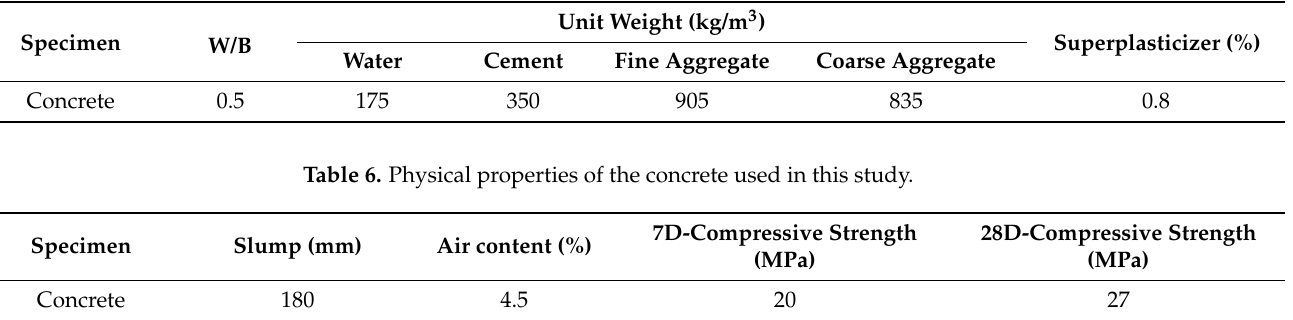
Table 5. Mix proportion of the concrete used in this study.